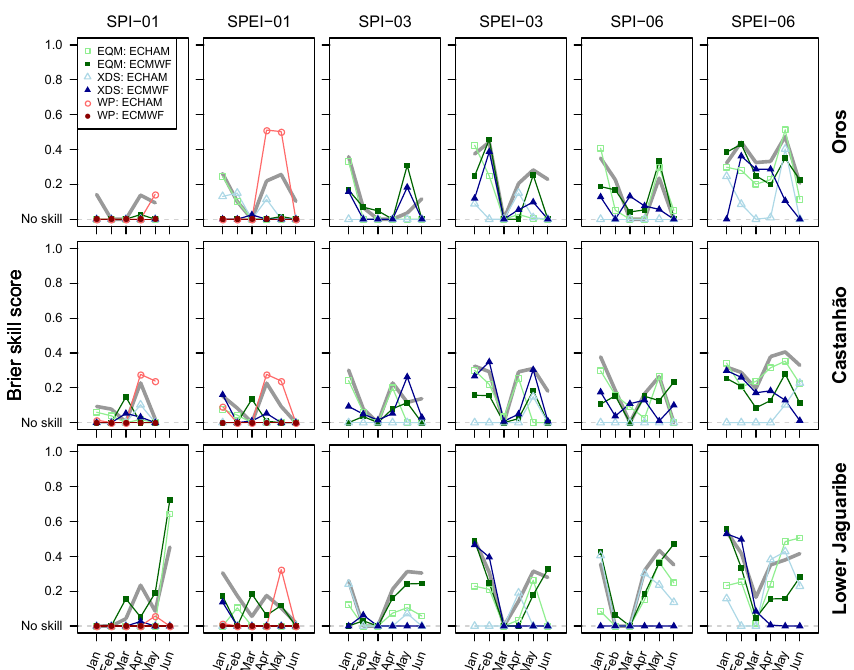
Figure 8. BSS of a forecasted meteorological drought event based on an event of index lower than − 1. The grey line shows the result of the multi-model ensemble